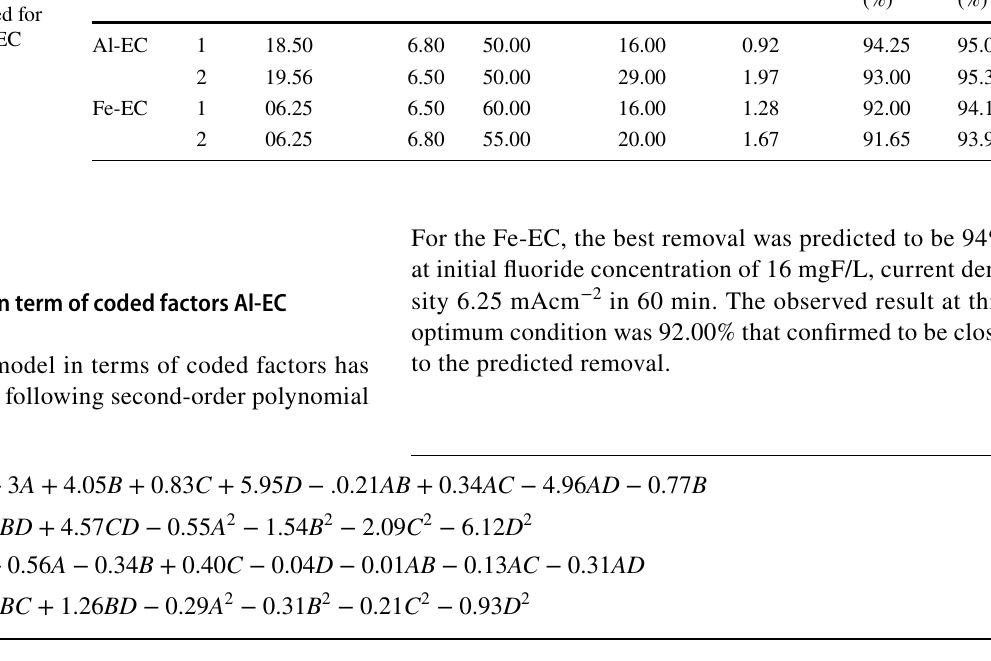
Table 4 Experimental and predicted results on a few selected solutions suggested for optimization tests for AL-EC and